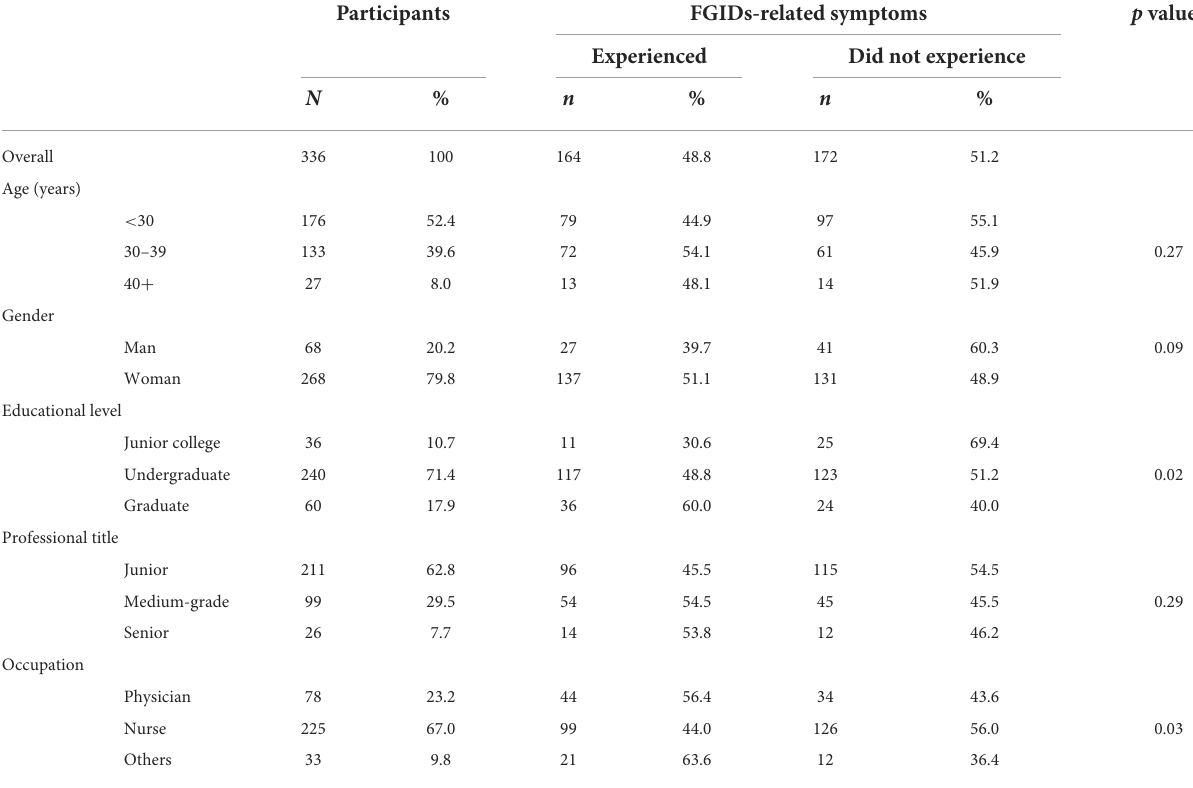
TABLE 2 The prevalence of FGIDs-related symptoms among participants in the study. Participants FGIDs-related symptoms p